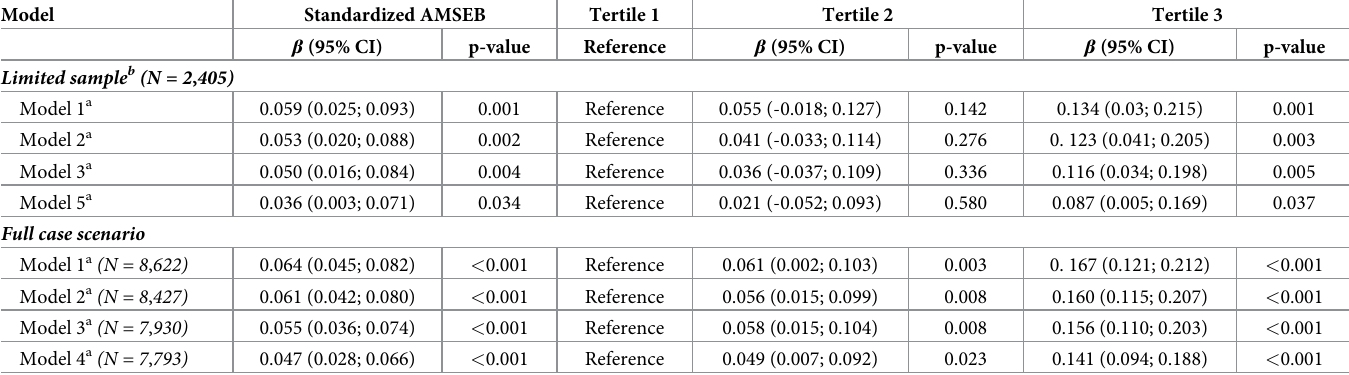
Table 4. Robustness analyses. Standardized Regression Estimates for the Association Between Baseline Adherence to Moral Standards and Ethical Behaviors and Purpose in Life over a Four-Year Follow-Up Period in Middle-Aged and Older Adulthood. Health and Retirement Study, US, 2012/2014–2016/2018, Full Case Scenario and Lim- ited Sample